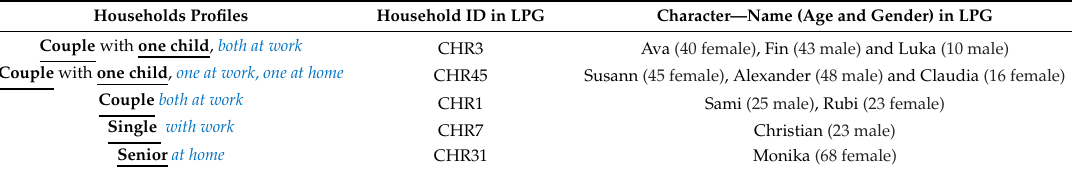
Table 3. The selected pre-defined household profiles in LPG based on Wepro model. Households Profiles Household ID in LPG Character—Name (Age and Gender) in LPG Couple with one child , both at work